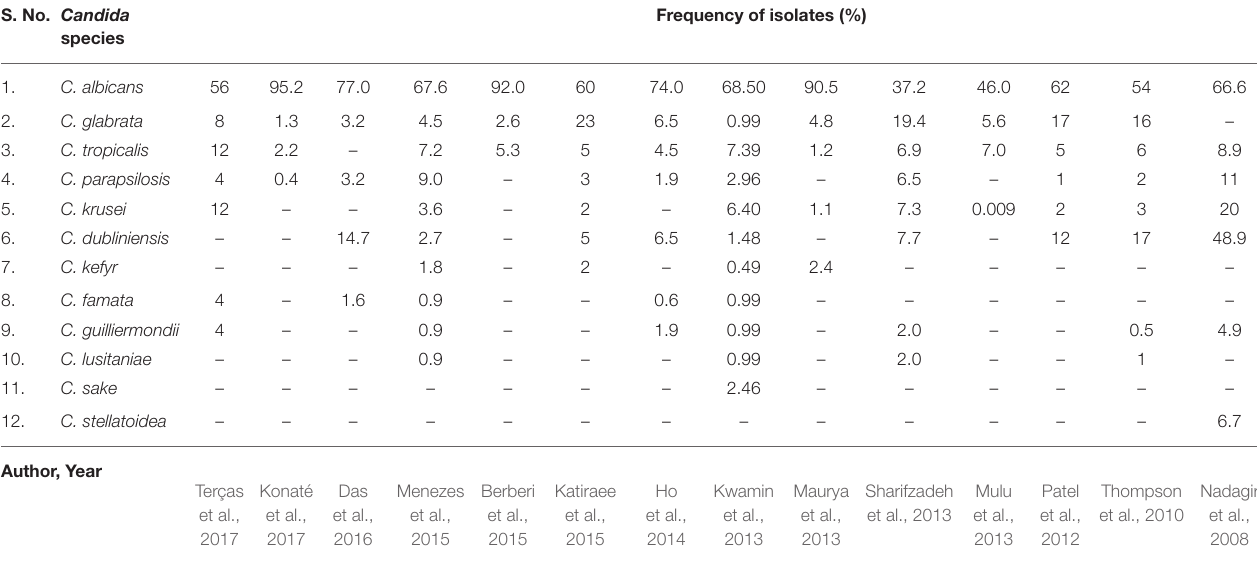
TABLE 2 | Isolation and frequency of different Candida species with respect to OPC in HIV-positive patients. S. No. Candida